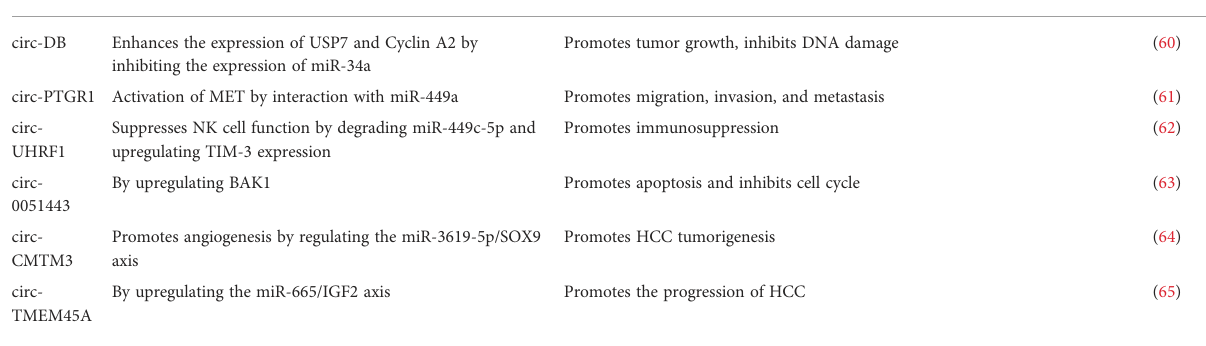
adhesion kinase ; CLEC3B, C-Type Lectin Domain Family 3 Member B ; AMPK, AMP-activated protein kinase ; VEGF, Vascular endothelial growth factor; CHI3L1, Chitinase-3-like protein 1; EIF3C, Eukaryotic Translation Initiation Factor 3 Subunit C; S100A11, S100 Calcium Binding Protein A11; PD-L1, Programmed death-ligand 1; PTEN, Phosphatase and tensin homolog ; B4GALT3, Beta-1,4-Galactosyltransferase 3; ZO-1, zonula occluden-1; Smad4, mothers against decapentaplegic family member4; STAT6, Signal transducer and activator of transcription 6; CDKN1A, Cyclin Dependent Kinase Inhibitor 1A ; TIMP2, Tissue inhibitor of metalloproteinases 2; EMT, Epithelial – mesenchymal transition; GADD45A, Growth